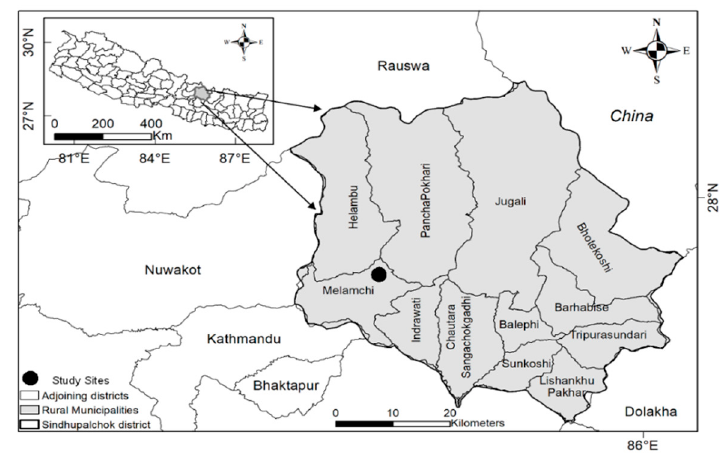
Figure 1. Map of Nepal Showing Study Area .